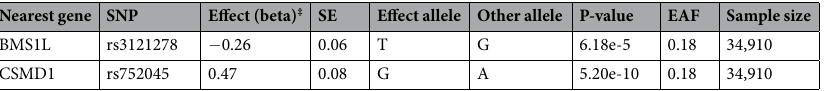
Table 1. Characteristics of the SNPs † used as genetic instrumental variables of handgrip strength (kg). BMS1L: BMS1-like ribosome biogenesis protein; CSMD1: CUB and Sushi multiple domains 1; SNP: single-nucleotide polymorphisms; SE; standard error; EAF: effect allele frequency. ‡ Effect on handgrip per kilogram per copy of the effect allele. † All information was obtained from “Matteini, A. M. et al . GWAS analysis of handgrip and lower body strength in older adults in the CHARGE consortium. Aging Cell, doi:10.1111/acel.12468